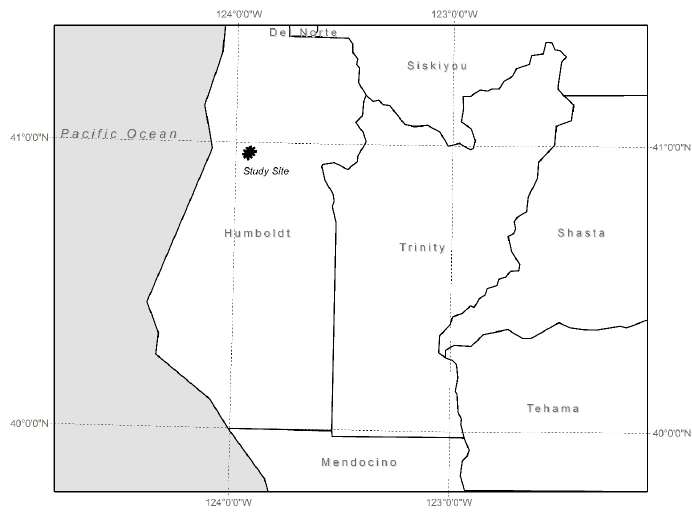
Figure 1. The locations of the study site used to develop the localized allometric models for coast redwood ( Sequoia sempervirens ) in Humboldt County, CA, USA. The stand was situated in an industrial timberland property.